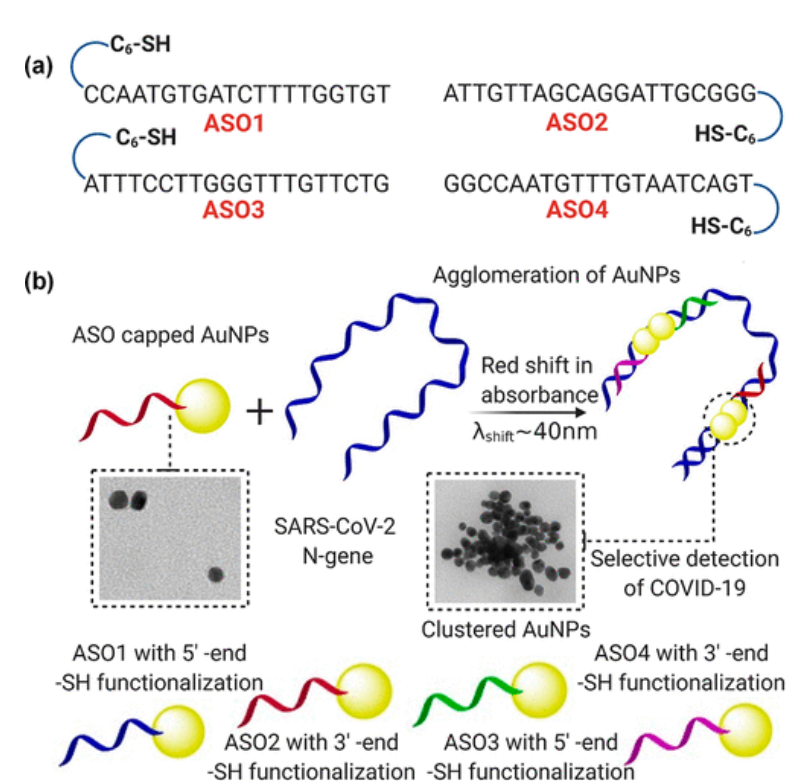
Figure 3. In ( a ) antisense oligonucleotides (ASOs) are shown with their different sequences and functions. ( b ) Schematically shows the proposed idea of accumulation of gold nanoparticles when capped with the ASOs (Adopted from Reference [100] with permission). https://pubs.acs.org/doi/abs/10.1021/acsnano.0c03822. Further permissions related to the material excerpted should be directed to the ACS.